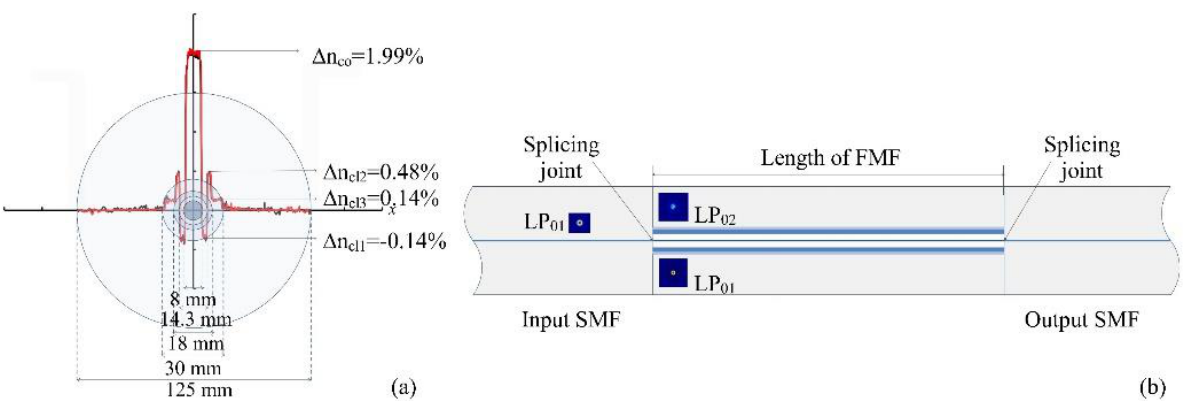
Figure 2. ( a ) Geometrical structure and relative refractive index difference profile of the few-mode fiber; ( b ) the SMF–FMF–SMF (SFS) structure. The insets are simulated mode field distributions of the LP 01 mode propagating in SMF and the LP 01 and LP 02 modes propagating in FMF at 1550 nm wavelength using the finite element model. SMF: single-mode fiber; FMF: few-mode fiber.